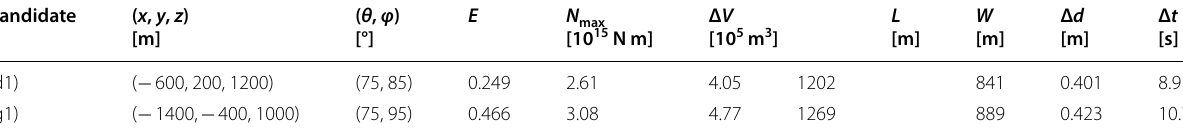
The notation is the same as in Table 2